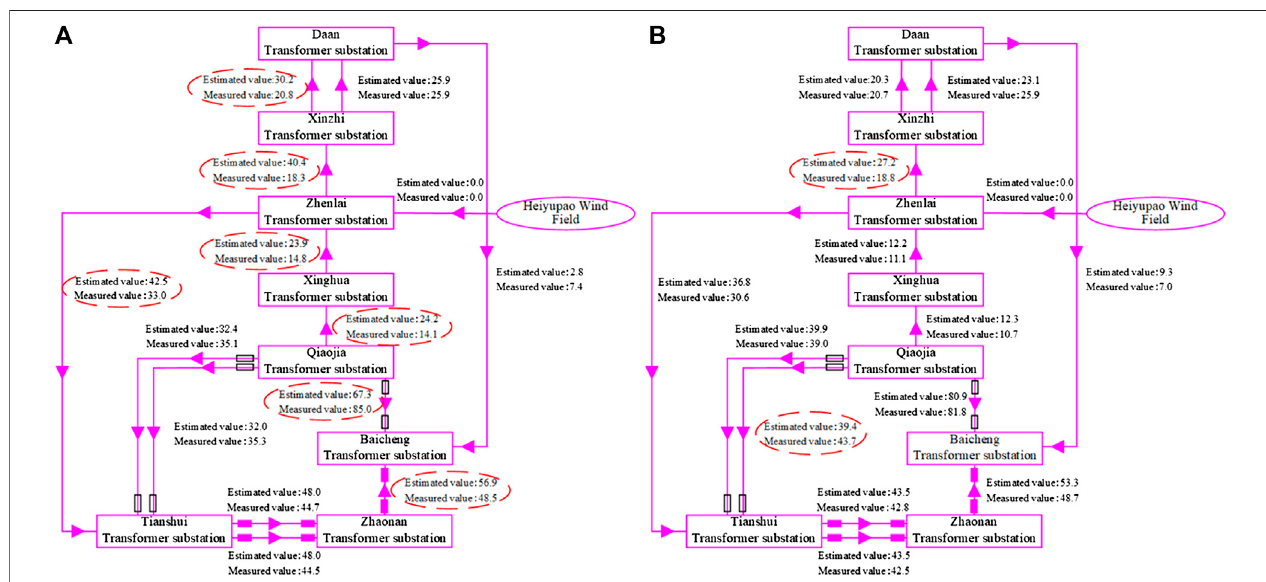
FIGURE 3 | Using original parameters (A) and optimized parameters (B) for state